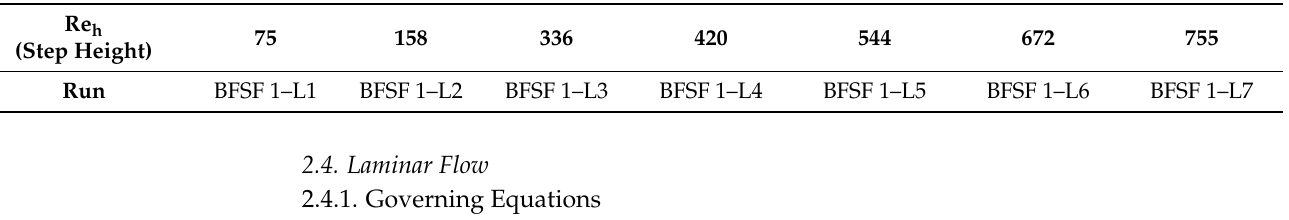
Table 2. Range of Reynolds numbers based on step height (Re h ) for the classical backward-facing